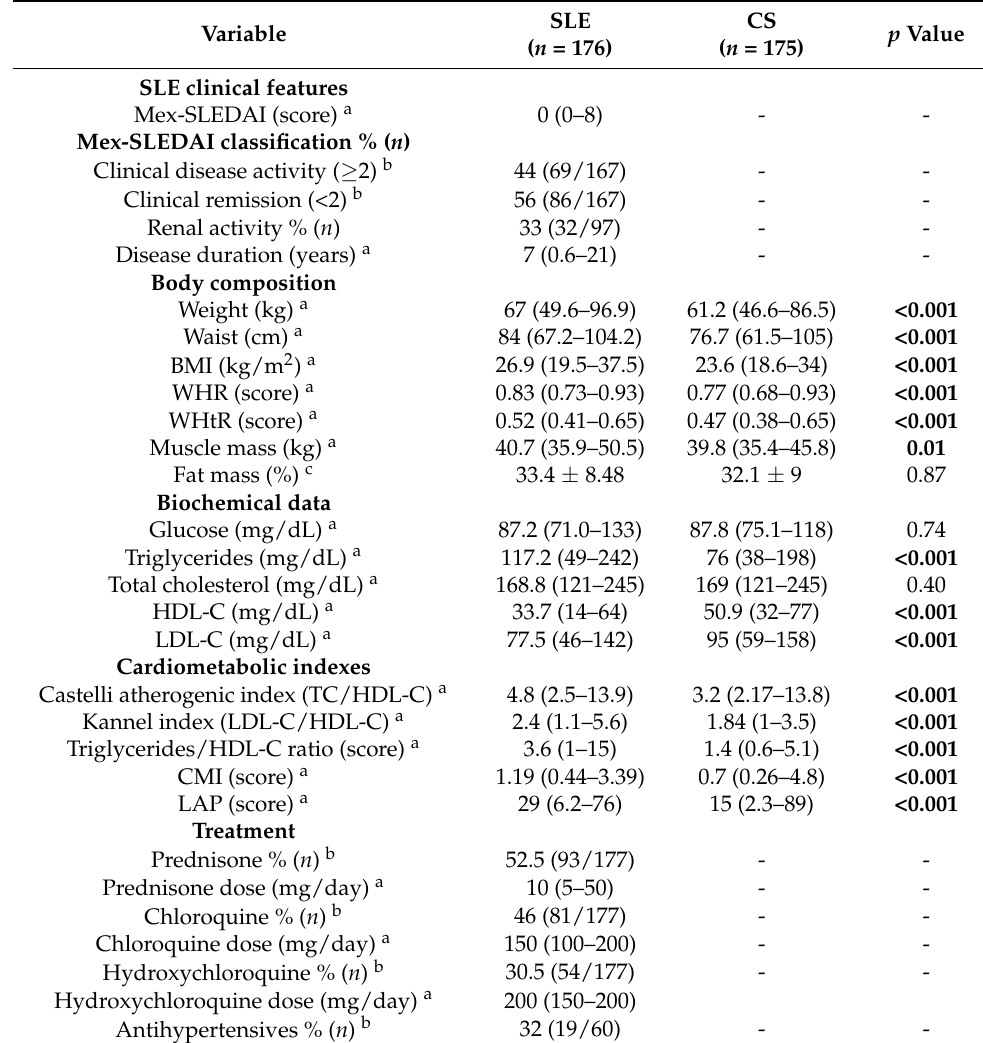
Table 1. General characteristics in SLE patients and